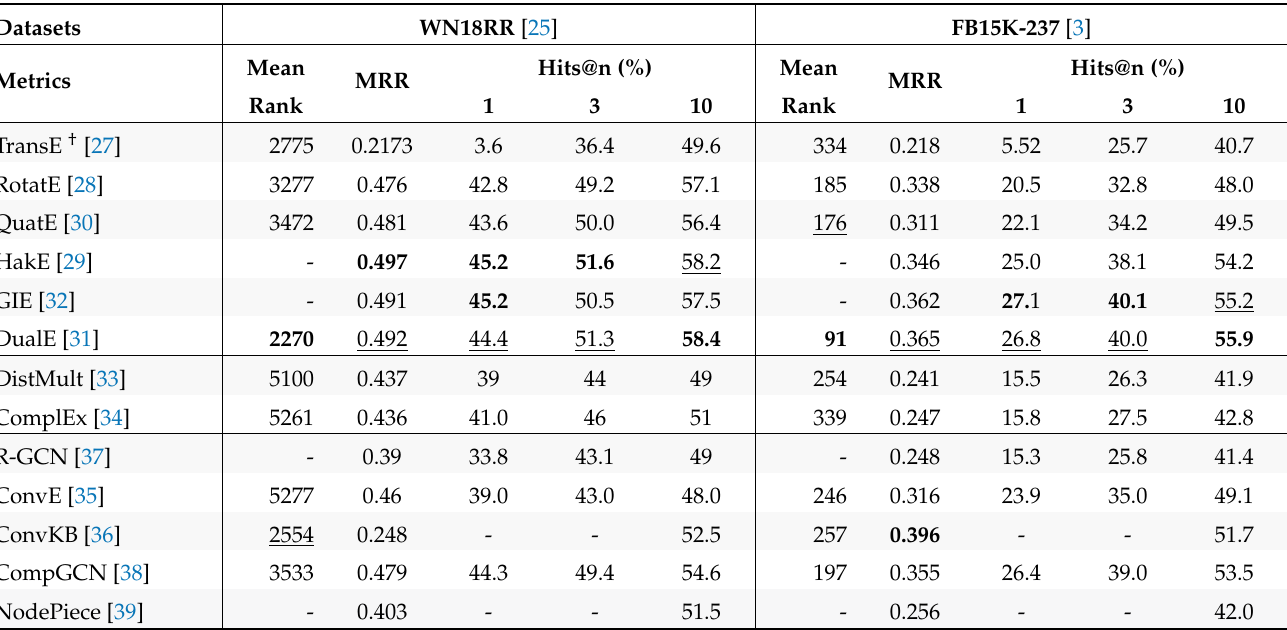
Table 6. Results on WN18RR and FB25K-237; † refers to our results. Bold and underline denote the best and second best scores.